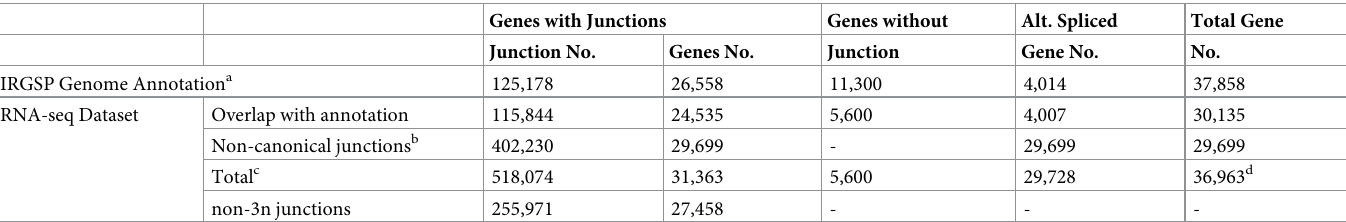
Total c 518,074